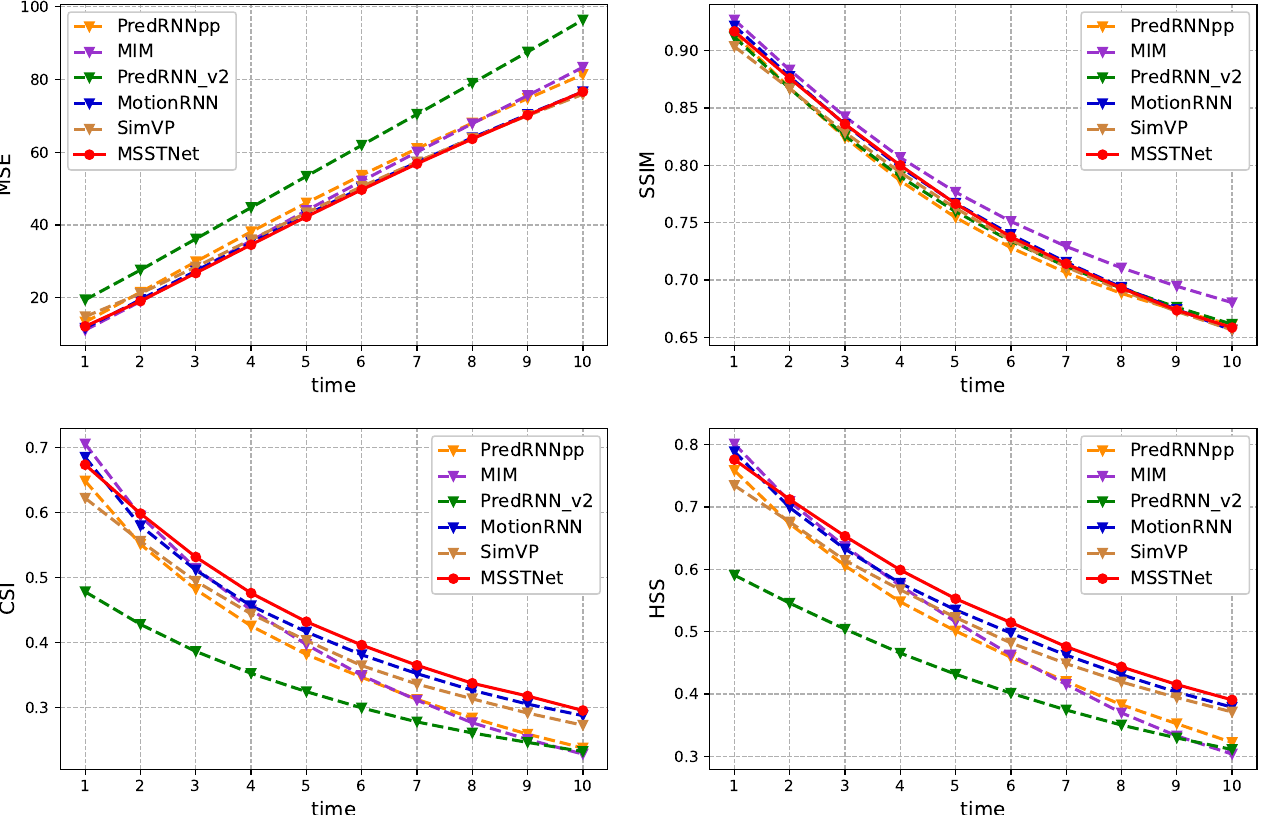
Figure 6. Compare the index of each frame in the Radar Echo